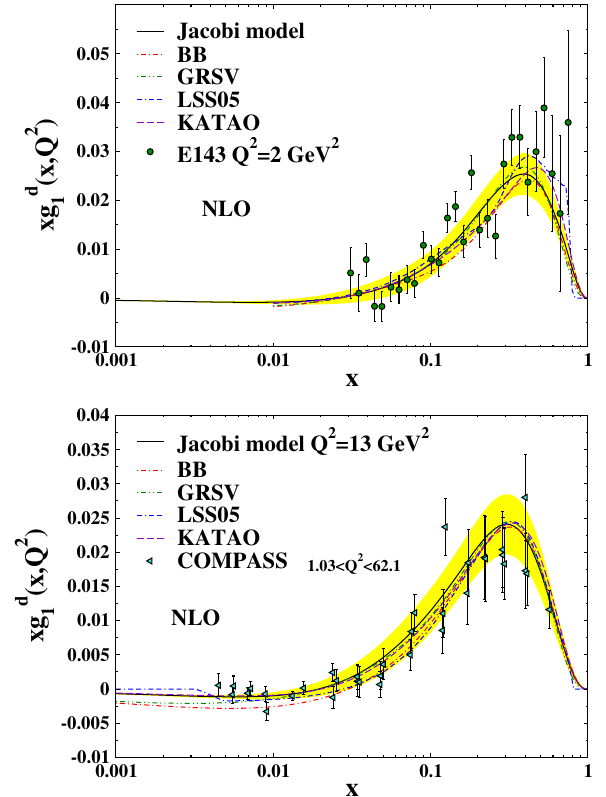
Fig. 6 The spin dependent of deutron structure functions as a function of x at Q 2 =2 GeV 2 and 13 GeV 2 . The result of Jacobi expansion technique (solid curve) is compared with parametrization models like BB (dashed-dotted) [61], GRSV (dashed-dotted-dotted) [119], LSS05 (dashed-dashed-dotted) [120] and KATAO (dashed) [74]